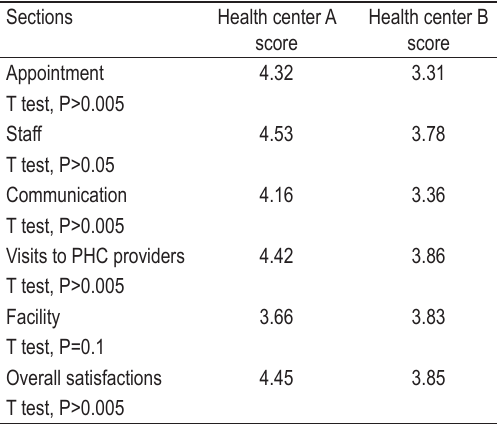
TABLE 2. Patient satisfaction in PHC center A and B – by